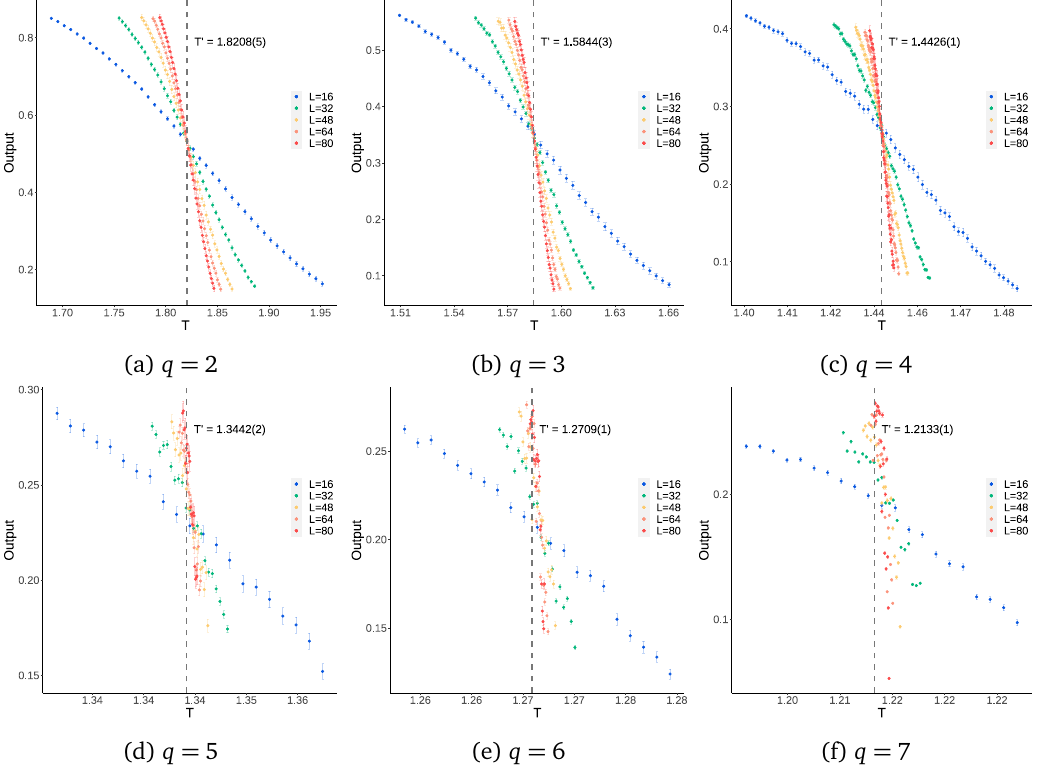
Figure 7: The relationship between temperature and the average output of an ensem- ble of 10 independently trained ANNs – training with MC data of the ferromagnetic square-lattice Ising model, and testing with MC data of the ferromagnetic q -state Potts model on a triangular lattice. The error bars shown are 99.7% confidence in- tervals of the ensemble